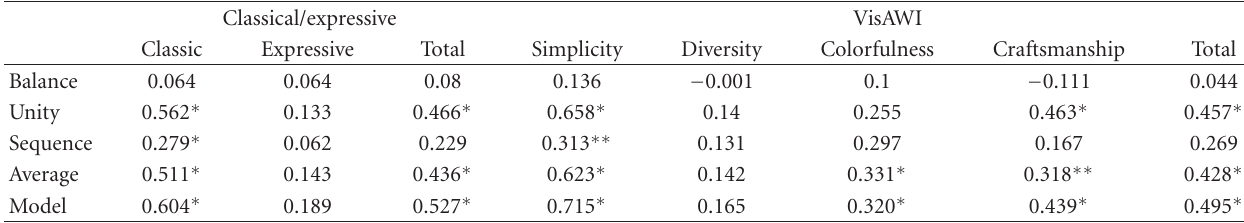
Table 6: Correlations between the measures and questionnaire